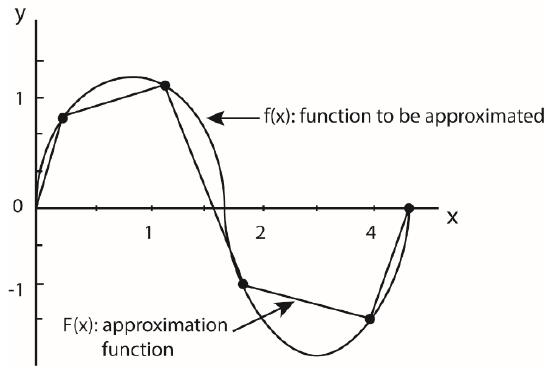
Figure 3. Illustration of approximation theory. A complex function f ( x ) is approximated by a simpler function F ( x ) using sample